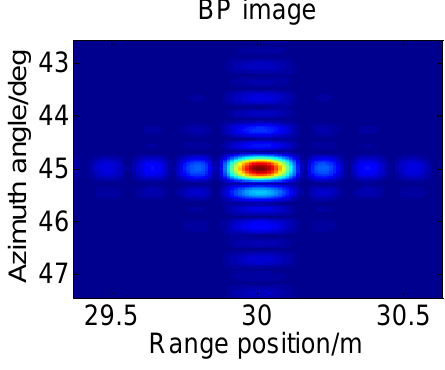
Figure 13. Image of edge point.